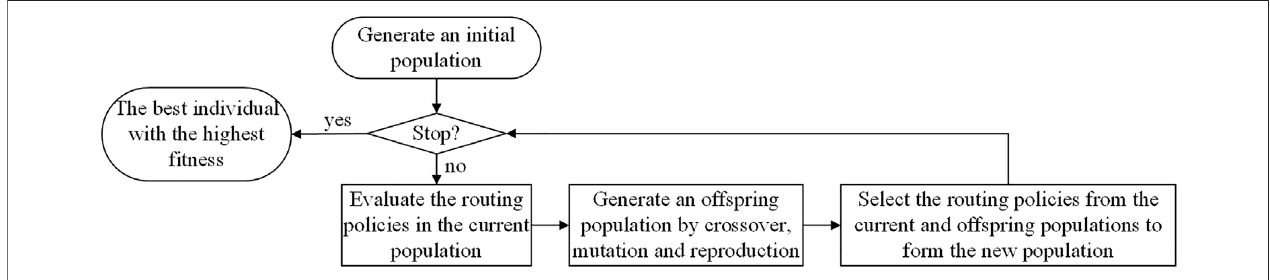
FIGURE 1 | The fl owchart of GPHH for